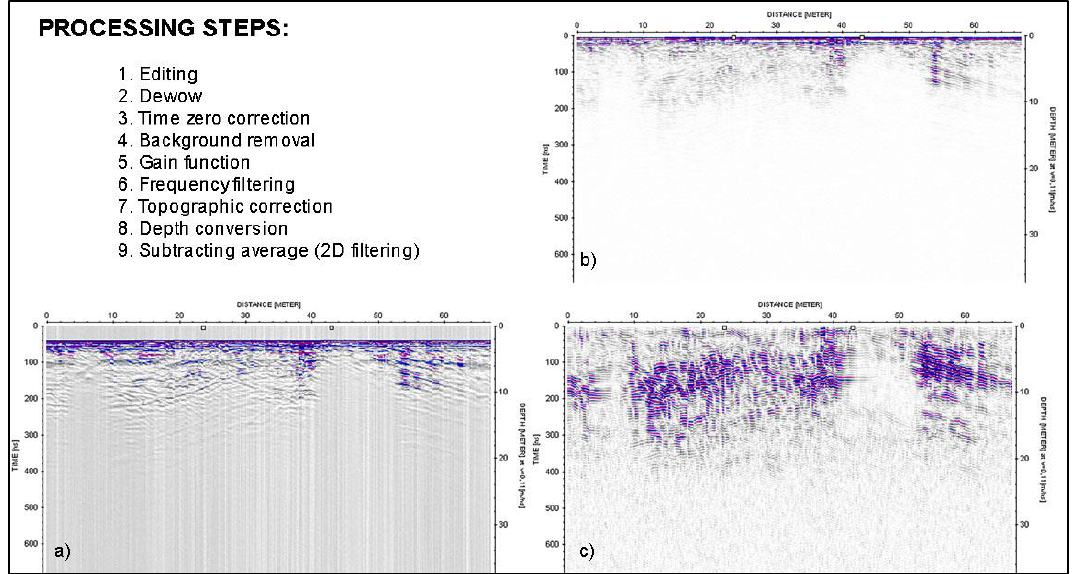
Figure 6. Processing steps (1 – 9) applied in profiles. Raw data and some processing steps are presented for Profile 1: ( a ) Raw data; ( b ) After dewow and time zero correction; ( c ) After background removal, manually-defined exponential gain correction, frequency and 2D filtering.